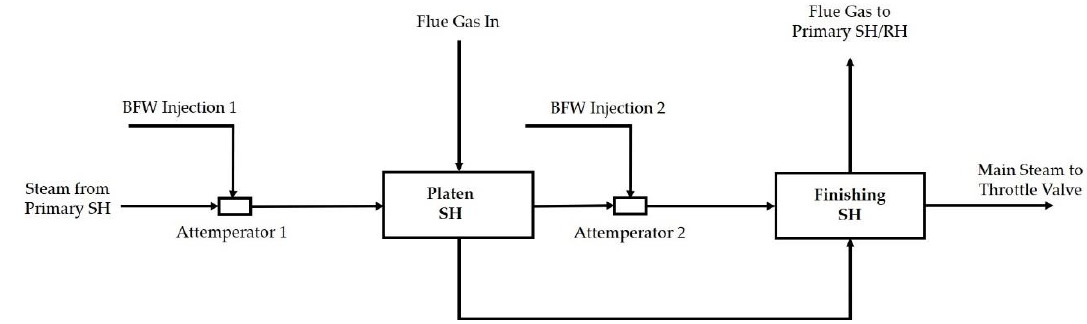
Figure 7. Schematic of High-Pressure Steam Attemperation.